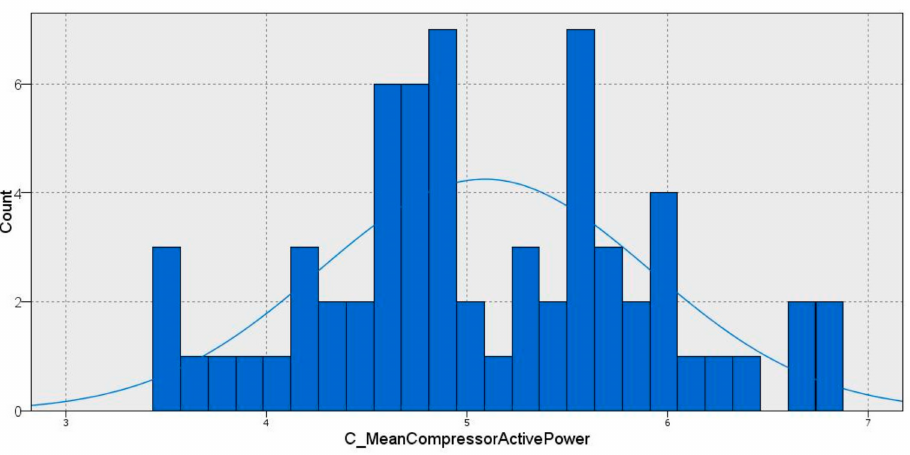
Figure 11. Gaussian distribution of energy consumption in cluster 3.3.